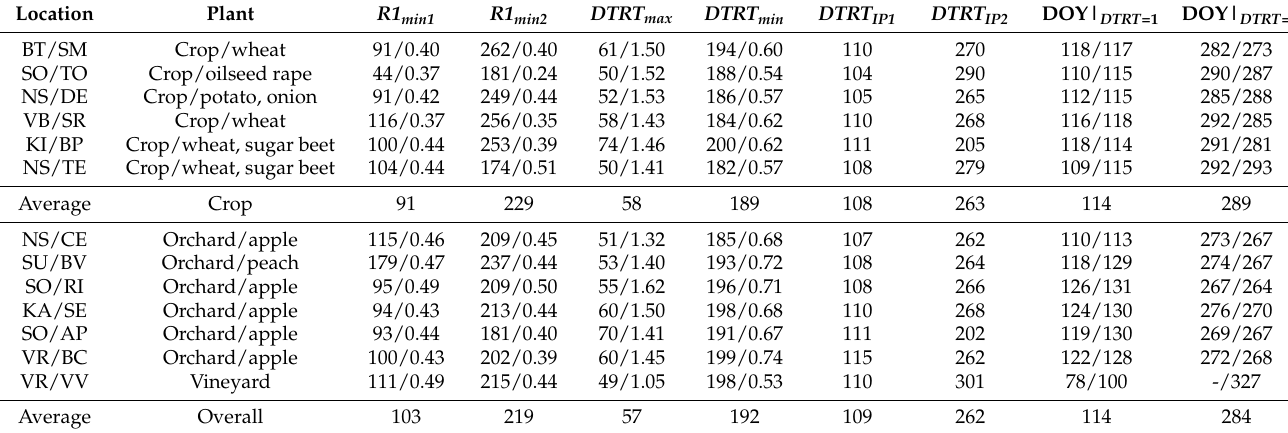
Table 6. Timing/magnitude of extreme values and IPs of R 1, R 2 and DTRT from GAM fit for